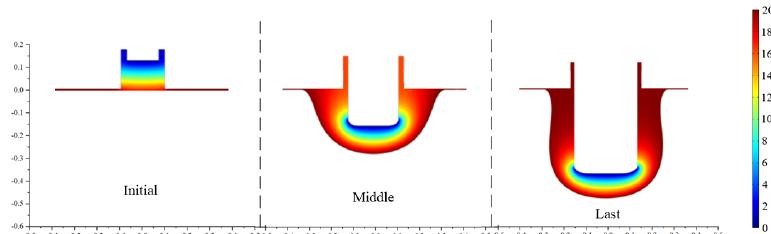
Figure 6. Simulation results of proposed tool structure with a 0.1 mm front tooth width.